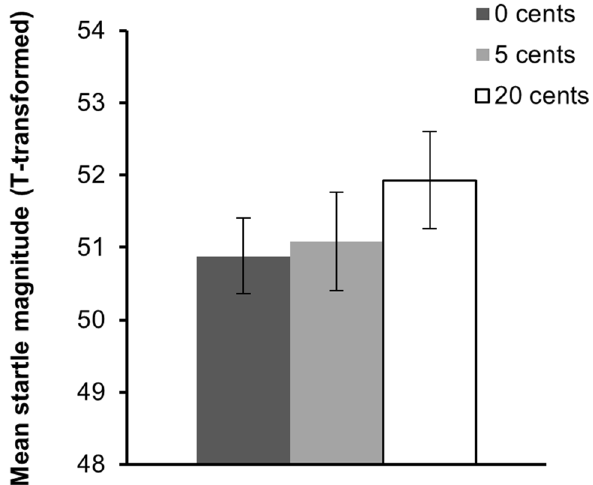
Figure 4. Mean startle magnitudes during the anticipation phase of the follow-up study. Startle magnitudes tended to be increased with increasing reward at stake. This effect was, however, not significant. Error bars represent ± standard error of the mean. Note that z -scores are transformed to t -scores for illustrative purposes.